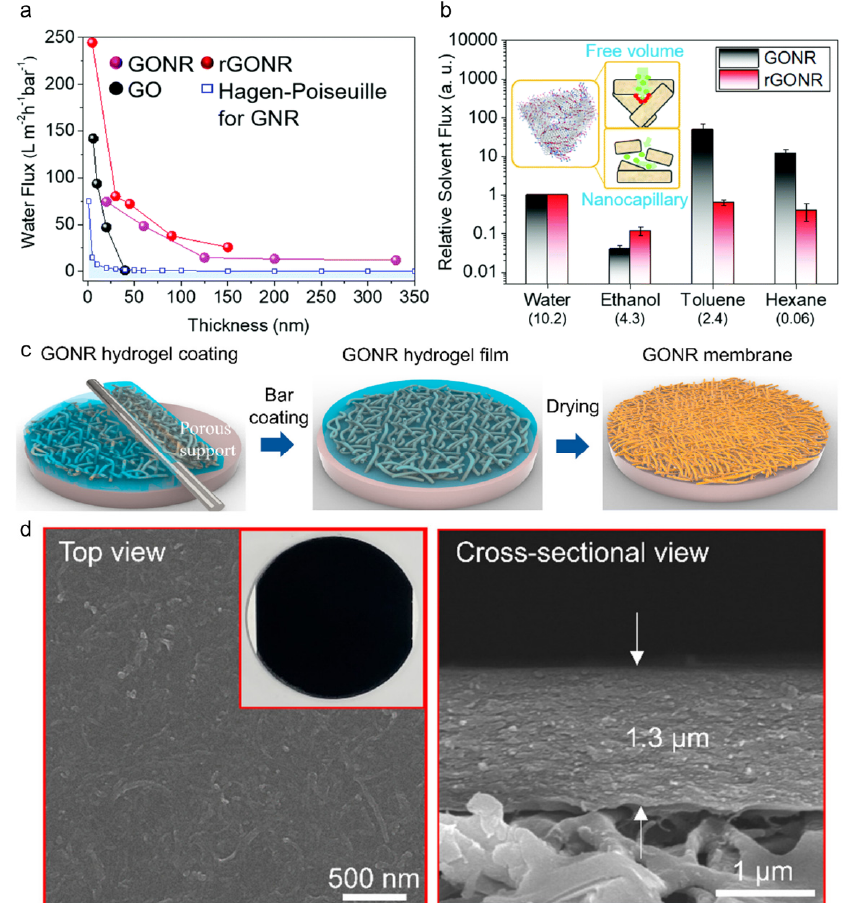
Figure 7. ( a ) Flux of pure water through the graphitic carbon membranes (GONR, rGONR, and GO) at different membrane thicknesses. ( b ) Relative flux of various solvents through the GONR and rGONR membranes of 100 nm thickness, normalized with water flux [78]. Copyright 2017 Royal Society of Chemistry. ( c ) Schematic of the GONR layer-coating procedure. ( d ) Top/cross- sectional SEM images of the GONR film after drying [8]. Copyright 2020 American Chemical Society.